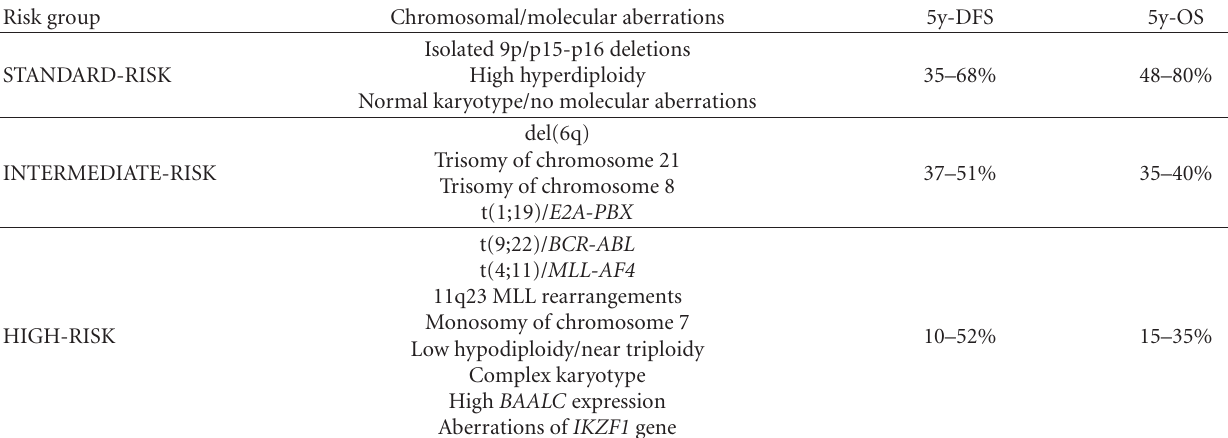
Table 2: Cytogenetic molecular classification of adult ALL based on more recently published data.